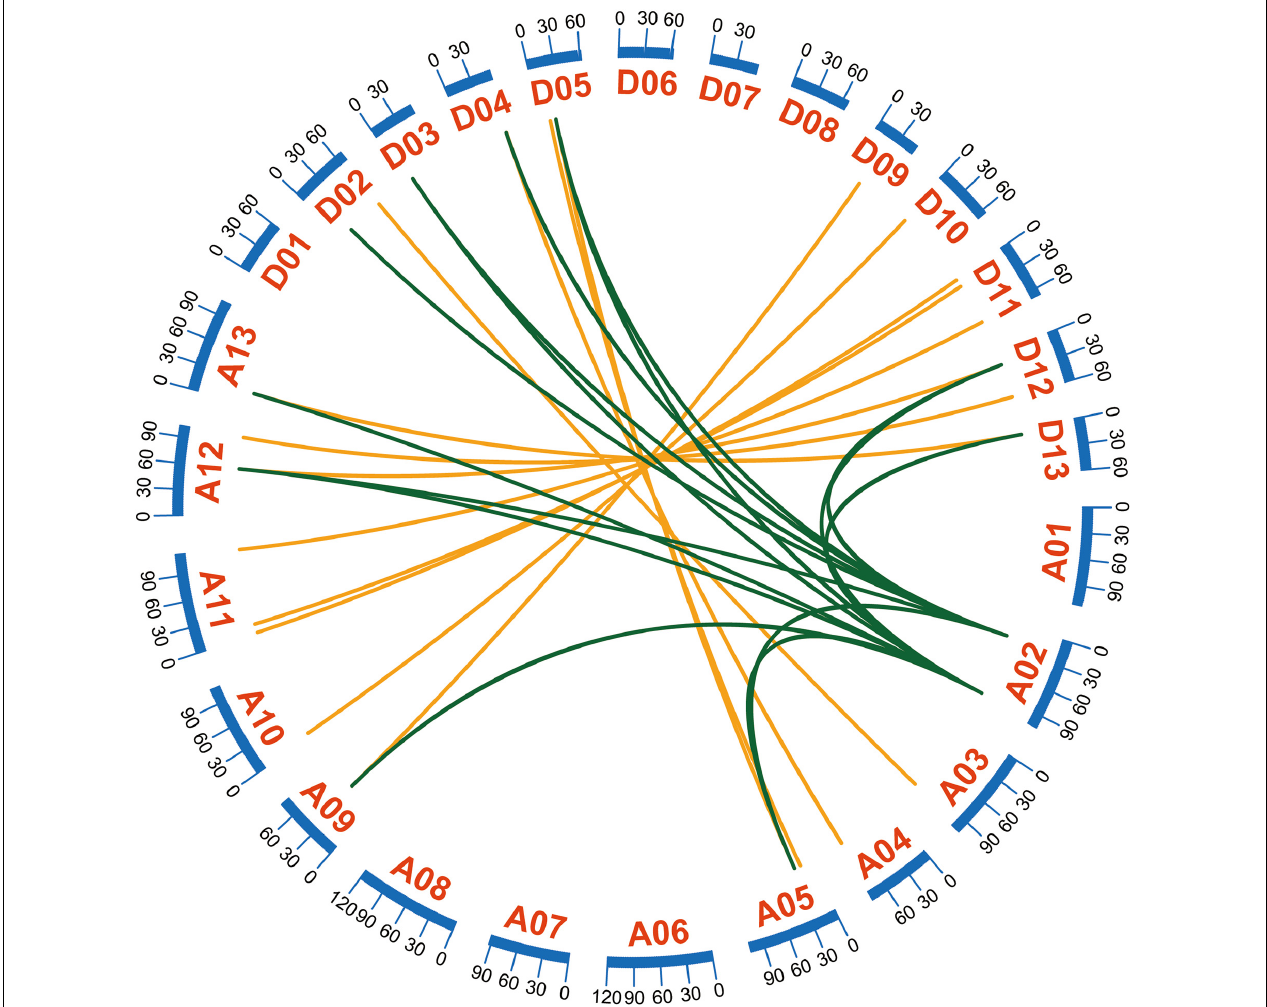
FIGURE 3 | Collinearity analyses of G. hirsutum EXO genes. Collinearity analyses of the GhEXO genes on the 18 chromosomes of G. hirsutum . A01–A13 represent chromosomes of the At sub-genome and D01-D13 correspond to chromosomes of the Dt sub-genome. Gene pairs formed by segmental duplication within the At and Dt sub-genomes are linked by green lines. The orange lines connect gene pairs identified on homologous chromosome pairs from the At and Dt